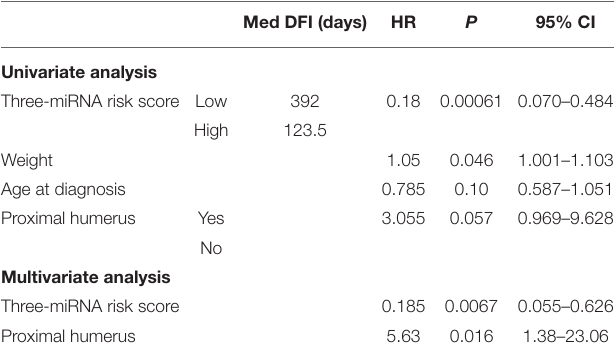
TABLE 5 | Results of univariate/multivariate analysis of factors associated with clinical outcome, including a three-miRNA expression-based risk score (tumor-derived miRNA